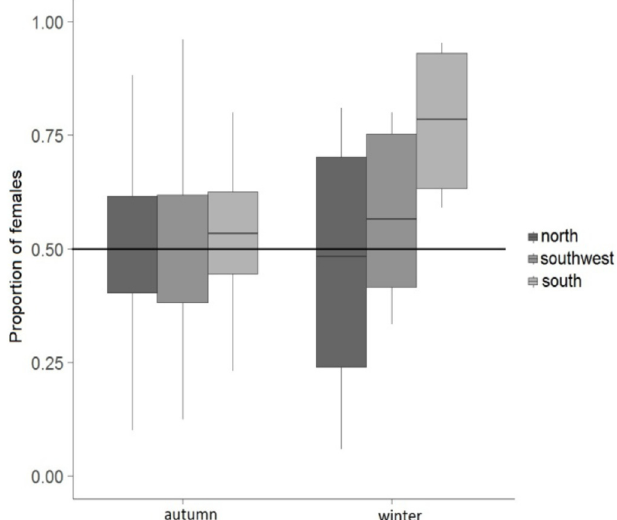
Fig. 3. Blue whiting proportion of females by season (autumn and winter) and area. The centre line of each box represents the median, the box limit indicates the 25th and 75th percentiles and the whisker delimits the non-outliers range. The horizontal line indicates the sex ratio